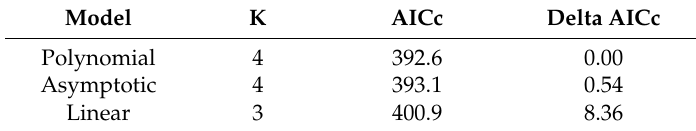
Table 1. Model selection for maximum temperature (combustibility) analysis.